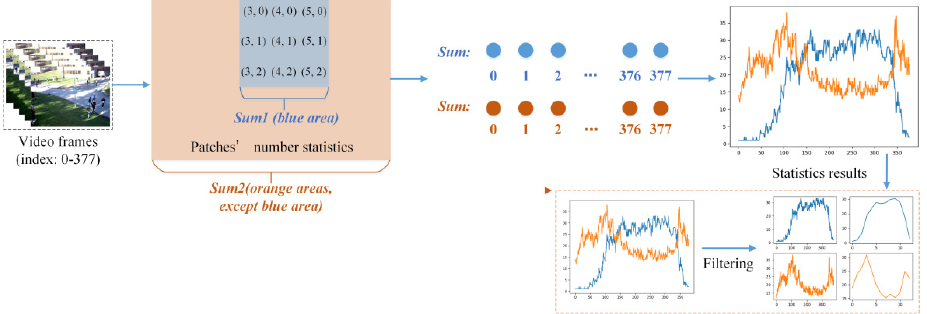
Figure 4. GJ for detecting the gathering